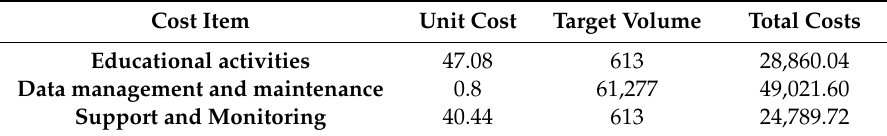
Table 5. Costs of selected items for the beFood co-production approach.